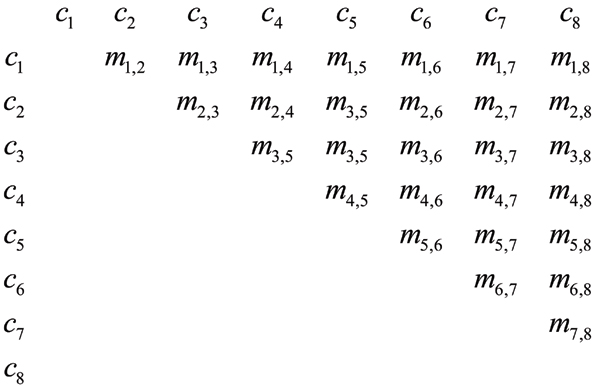
Categories (Ci) and submodels (mi, j) in PMC-SVM.